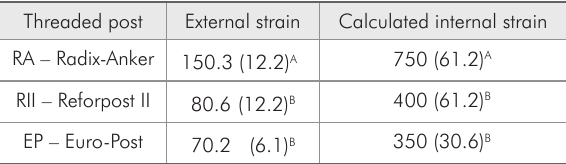
Table 1 - Mean strains values (SDs) and statistical catego- ries defined by the Tukey test (n = 5;